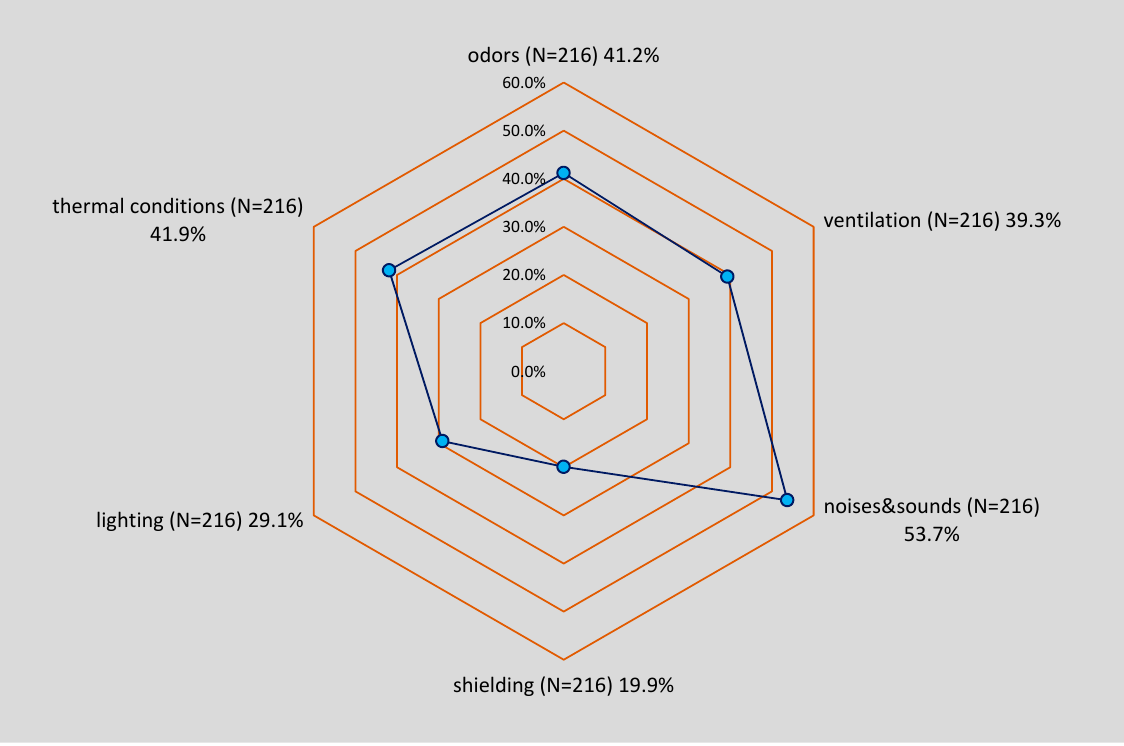
Figure 3. The number of respondents who considered their wellbeing negatively affected by certain IEQ parameters ( N = 216).